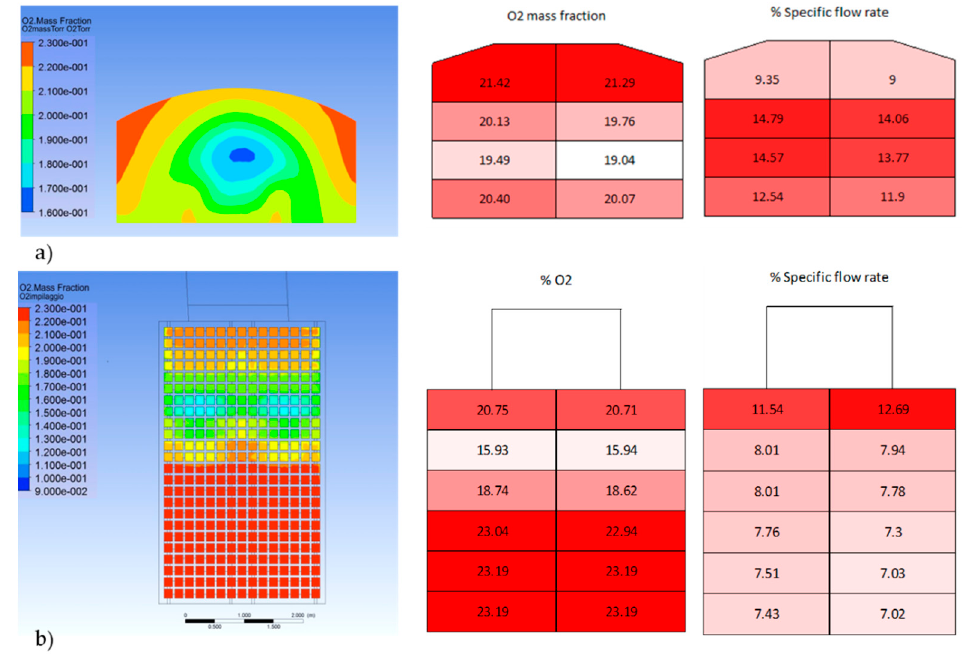
Figure 13. ( a ) Exhaust mean gas fraction at the port neck and ( b ) at the checkers section.